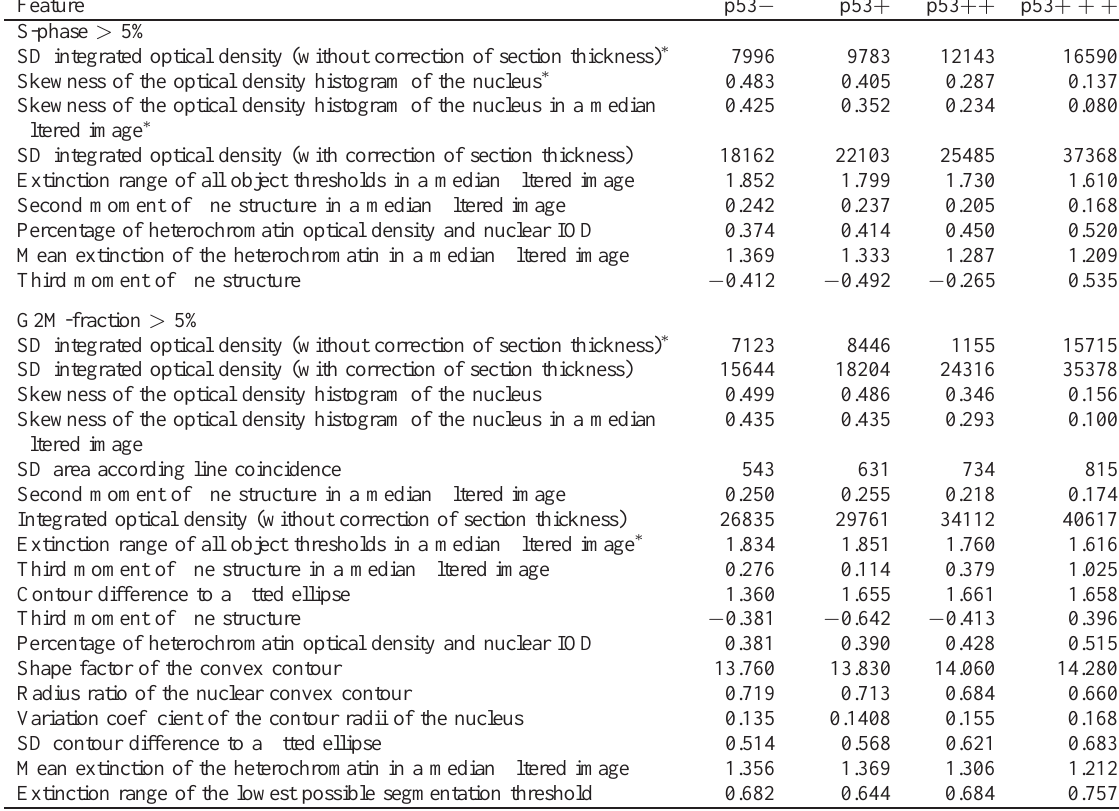
Table 9 Significant differences in the nuclear subpopulations with different p53 expression in the p53 positive tumours with a S-phase and a G2M-fraction higher than 5% ( p < 0 .